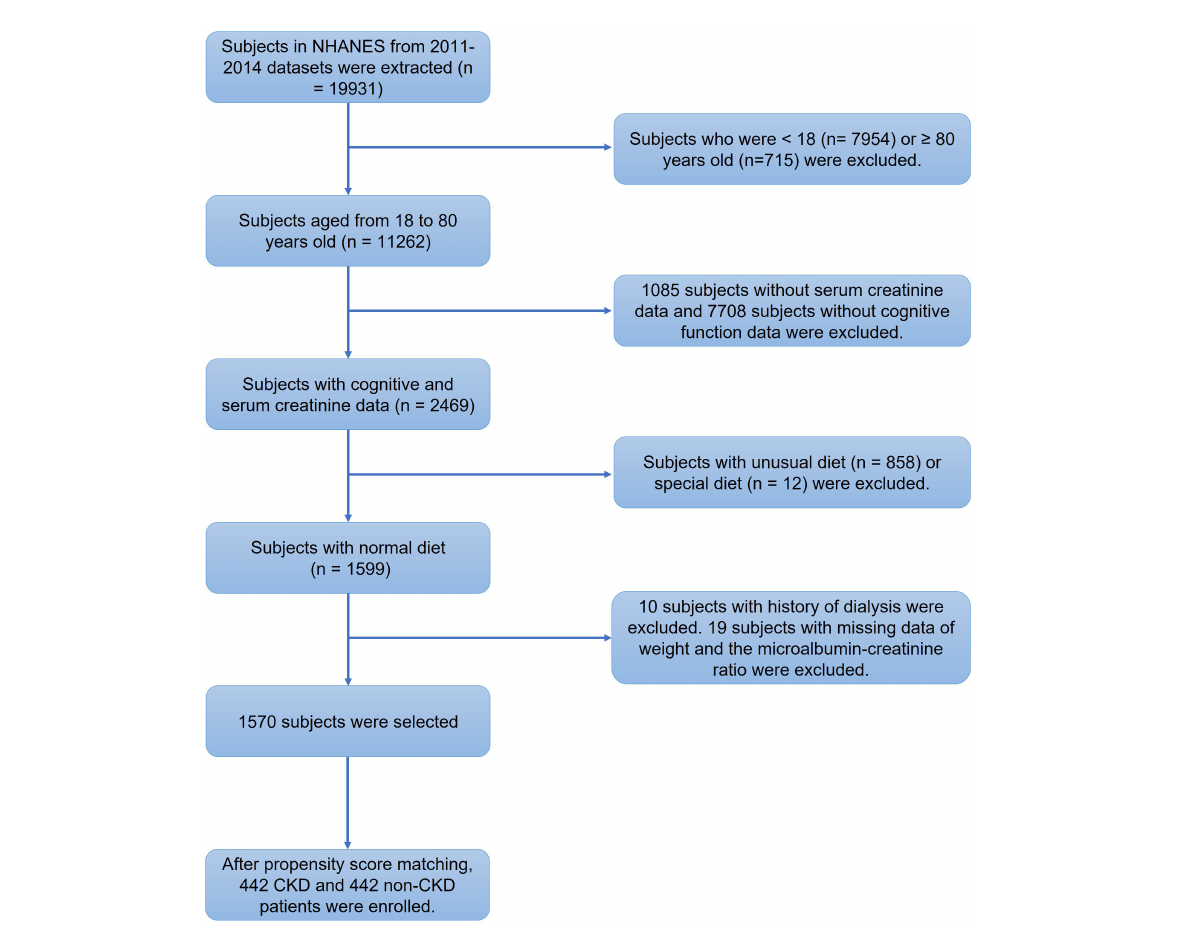
FIGURE2 Flowchart of the screening process for eligible subjects. We extracted the clinical data of 19931 subjects from the National Health and Nutrition Examination Survey (NHANES) 2011–2014 database. We first excluded 7954 subjects under 18 years old and 715 subjects aged more than 80 years old. Then, 8793 subjects with missing serum creatinine or cognitive evaluation data were excluded. We also excluded 870 subjects with special diets. Among the remaining 1599 subjects, 10 subjects with a dialysis history and 19 subjects without diagnostic prerequisites for chronic kidney disease (CKD) were excluded. Then, 1570 subjects were enrolled for analysis. After propensity score matching, 442 CKD patients and 442 non-CKD subjects were finally